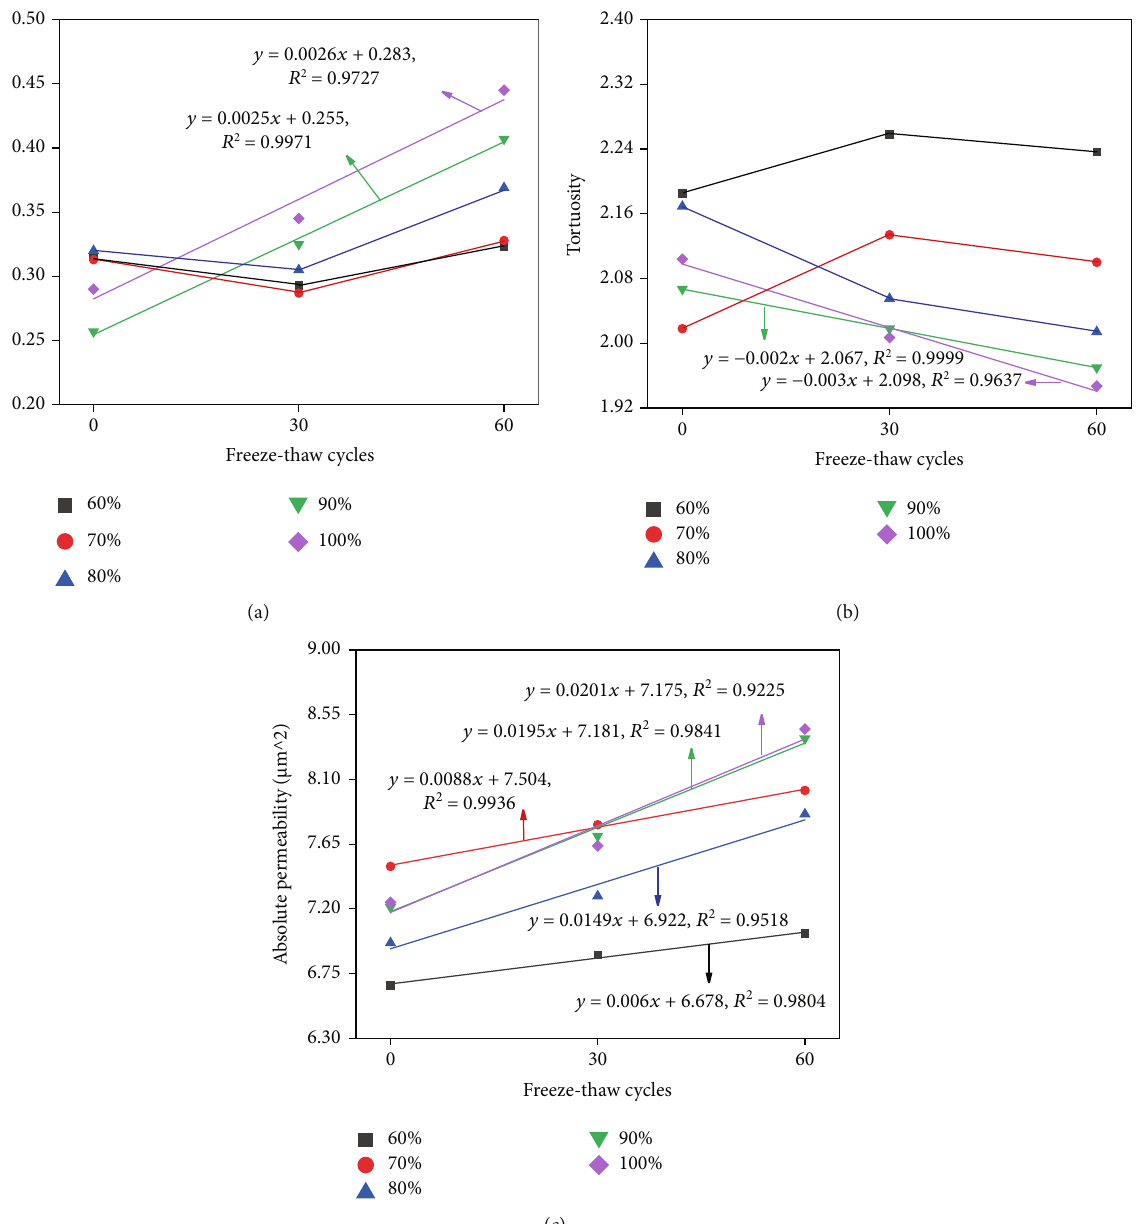
Figure 12: Connectivity curves of fi ve red sandstone samples with di ff erent saturations after 0, 30, and 60 freeze-thaw cycles. (a) Average coordination number. (b) Tortuosity. (c) Absolute